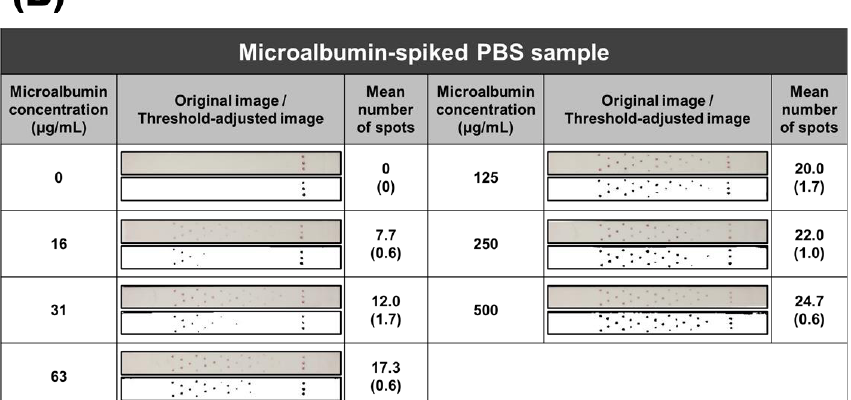
Figure 5. Quantitative analysis of microalbumin-spiked PBS samples. ( A ) The calibration curve of the various concentrations of microalbumin in PBS samples. ( B ) Original and threshold-adjusted images obtained from the immunoassay strip. The SD values are shown in parentheses.